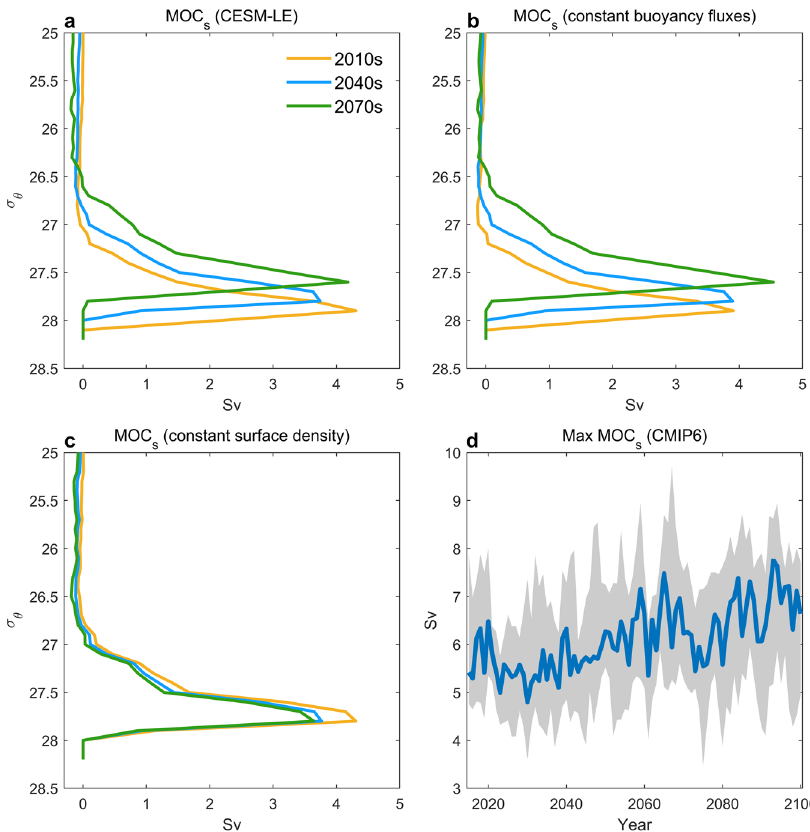
Fig. 7 | Surface-forced watermass transformation. a Decadal changes in surface- forced water mass transformation (MOC s ; Equation (3)) in CESM-LE calculated for the area 70-80°N, 35°W-20°E. The three lines show the ensemble mean for 2010 – 2019, 2040 – 2049, and 2070 – 2079. b , c As ( a ) but calculated using constant (seasonal climatology) buoyancy fl uxes and constant surface density fi eld,